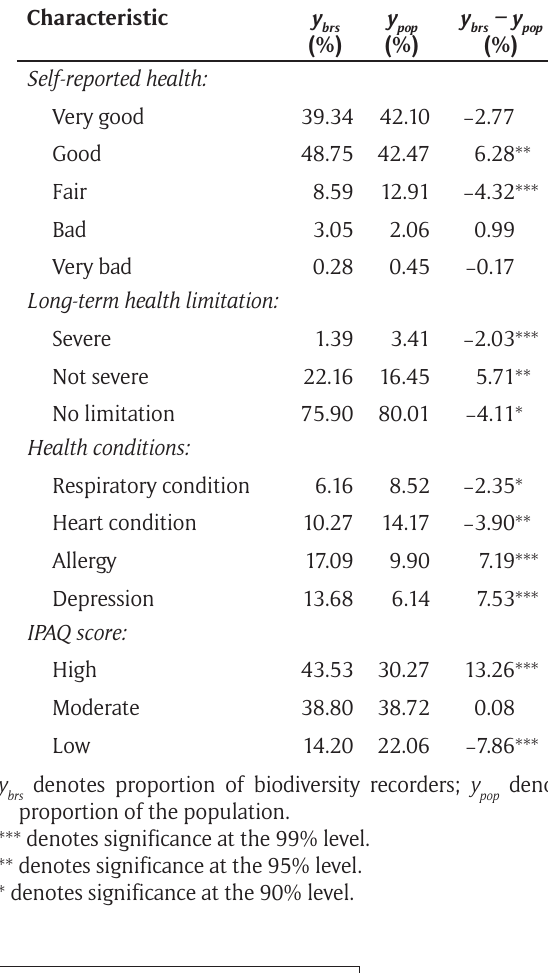
Table 3: Health and well-being characteristics of biodiver- sity recorders compared with those of adult population in Ireland using Healthy Ireland Survey